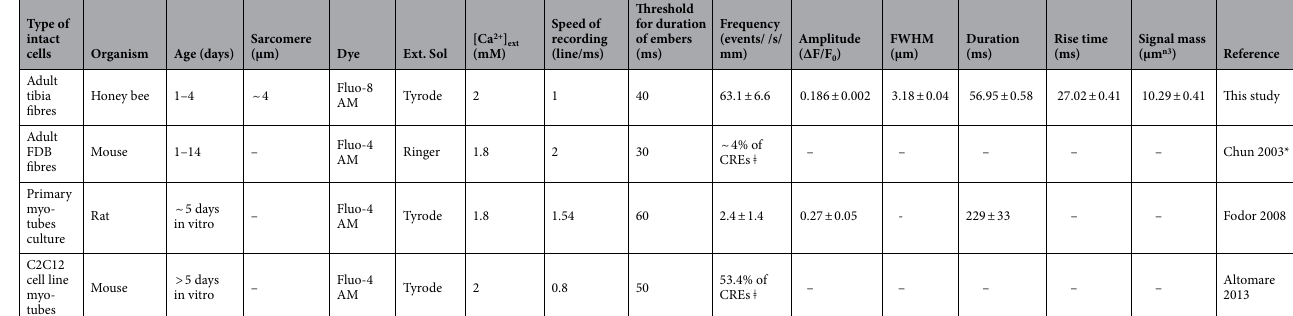
Table 4. Interspecific comparison of calcium embers’ parameters measured in line-scan (XT) experiments performed in intact cells. In this table studies are ordered according to i) the developmental stage and ii) the species (Honey bee, Frog, Mouse, Rat). Preparations were freshly isolated muscle fibres or cell culture. *Chun values are from EDL and diaphragm muscles. Rise time was calculated between 10–90% of the peak amplitude. ǂ The embers frequency was given as a percentage of total CRE in these studies. Data marked with ~ is approximated from figures. All data depicted at room temperature. FDB – flexor digitorum brevis; AM – acetoxymethyl ester; FWHM – full width at half